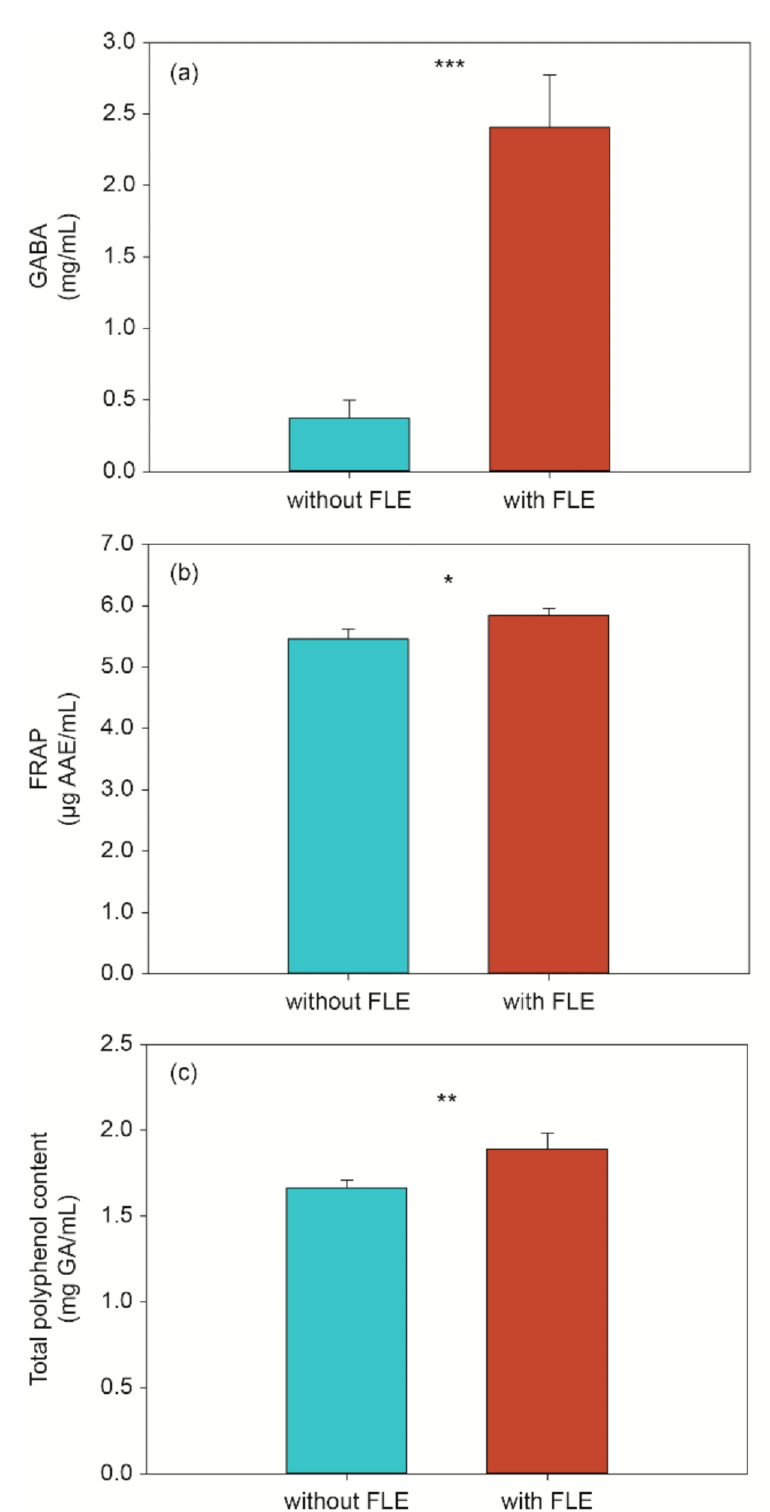
Figure 1. Level of ( a ) GABA, ( b ) antioxidant activity, and ( c ) total polyphenols in standard (without fermented lettuce extract (FLE)) and noodles with FLE (with FLE). The data are shown as the mean ± standard deviation and represent three replicate measurements. Significant difference set as * p < 0.05, ** p < 0.01, and *** p <